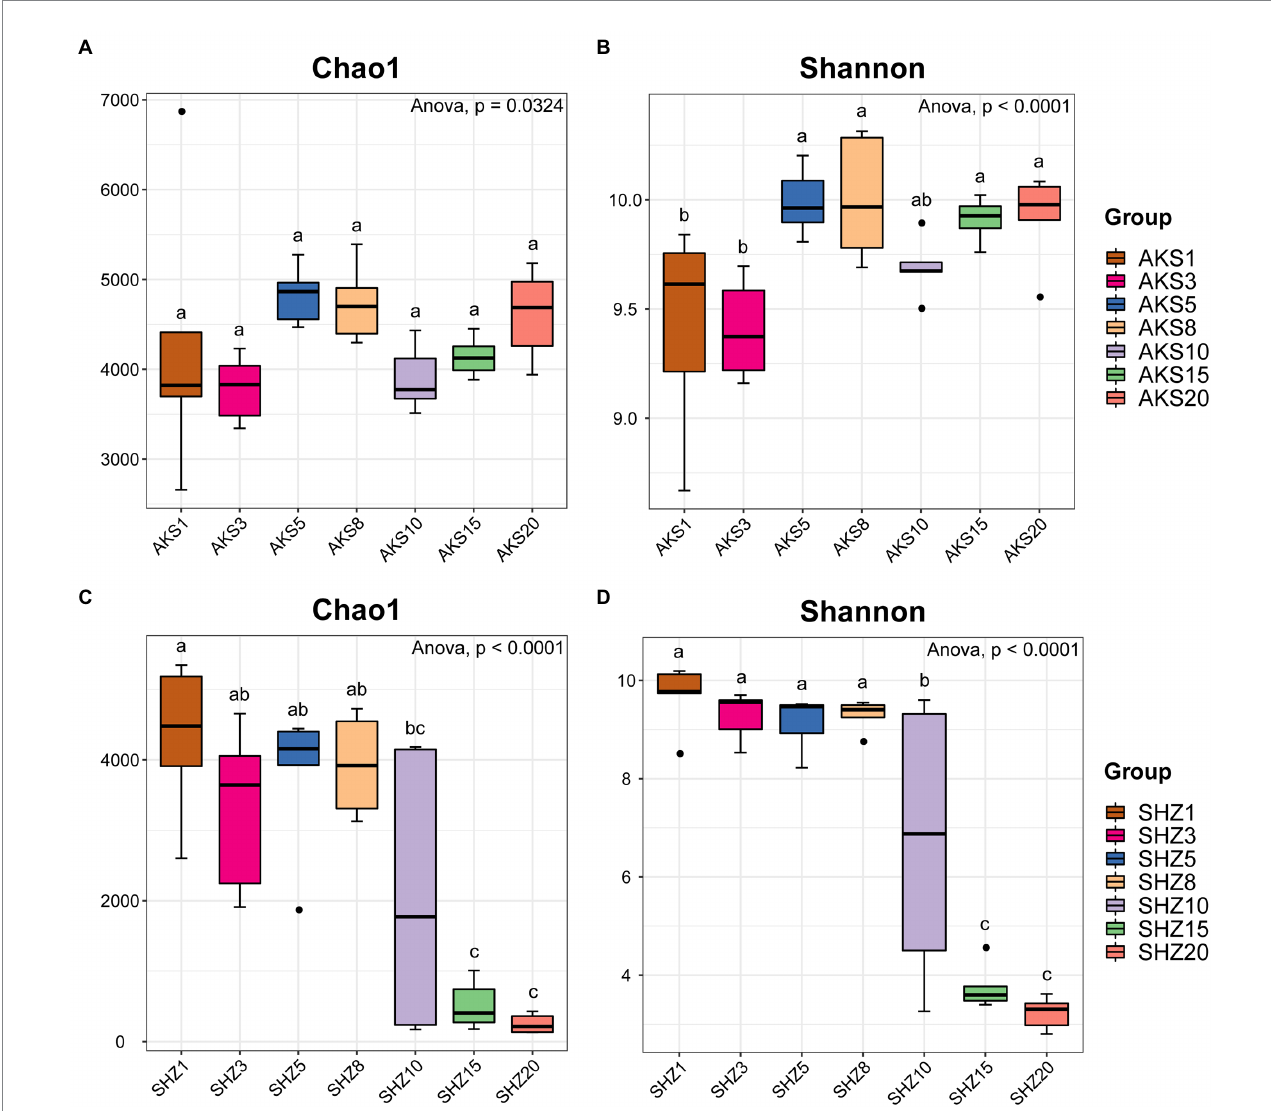
FIGURE 1 Chao1 index (A,C) and Shannon index (B,D) of cotton field soil samples bacterial community with different continuous cropping years in AKS and SHZ soils. AKS1, AKS3, AKS5, AKS8, AKS10, AKS15, and AKS20: AKS soils of continuous cropping 1, 3, 5, 8, 10, 15, and 20 years; SHZ1, SHZ3, SHZ5, SHZ8, SHZ10, SHZ15, and SHZ20: SHZ soils of continuous cropping 1, 3, 5, 8, 10, 15, and 20 years. The letters ‘a’, ‘b,’ and ‘c’ represent statistically significant differences between different treatments ( p < 0.05, Tukey